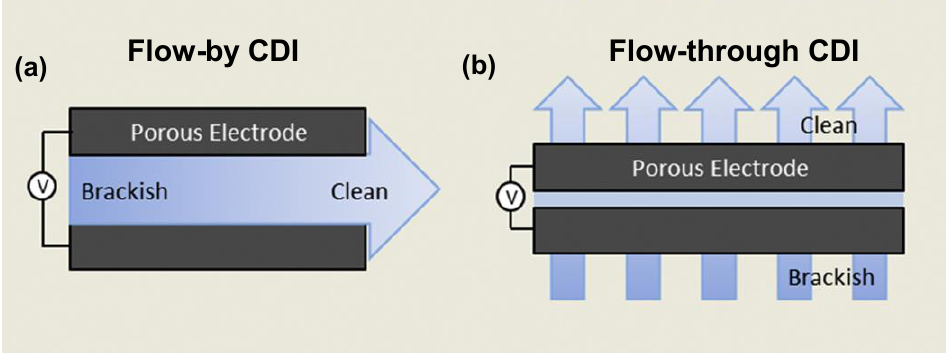
Figure 2. Comparison of ( a ) flow-by CDI cell and ( b ) flow-through CDI cell with porous electrodes. Reproduced with permission from [3]. Copyright 2013 Elsevier.